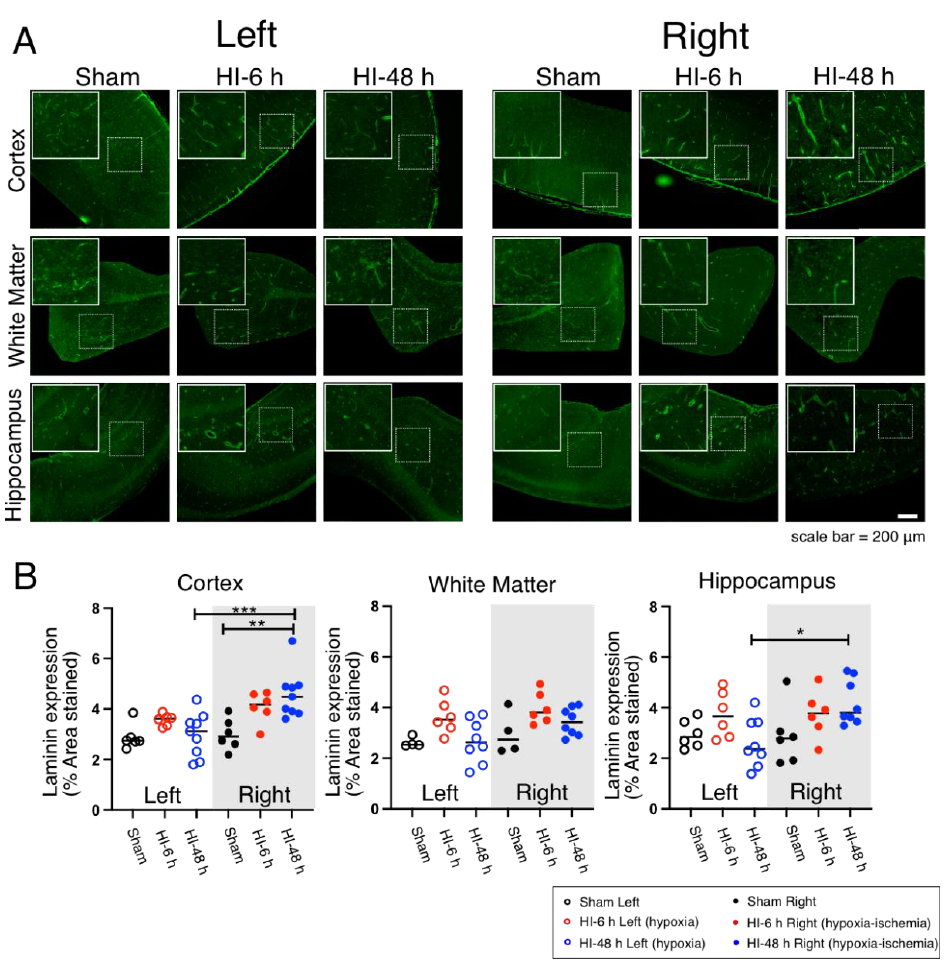
Figure 1. Immunohistochemical images and quantification of microvessels in the cerebral cortex, white matter, and hippocampus on the left hypoxic and right HI sides in the brain of the neonatal rats in the Sham, HI-6 h, and HI-48 h groups. ( A ) Representative images of microvessels (laminin, Green) in the cerebral cortex, white matter, and hippocampus in neonatal rats. Magnification, 10×. Each inset contains high magnification images. Scale bar = 200 μm. ( B ) Quantification of microvessel density shown by laminin expression (% Area Stained) in the cerebral cortex, white matter, and hippocampus of left hypoxic and right HI sides of rat brain in Sham (left; black open circles, right; black closed circles), HI-6 h (left; red open circles, right; red closed circles), and HI-48 h (left; red open circles, right; red closed circles). Values ’ median and dot plots. * p < 0.05, ** p < 0.01, *** p < 0.001.